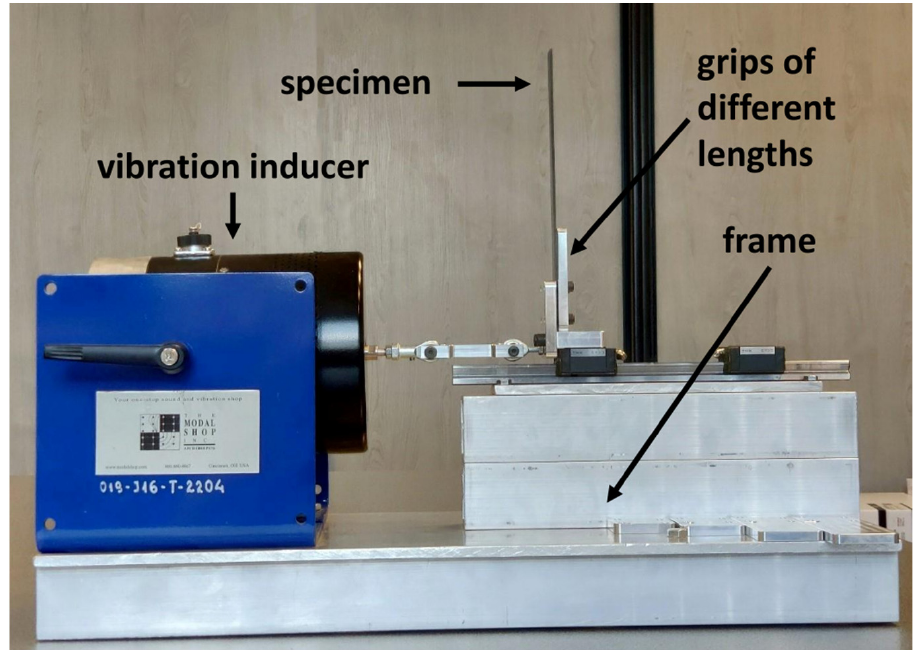
Figure 6. Manufactured test bench for experimental verification of the presented formula.